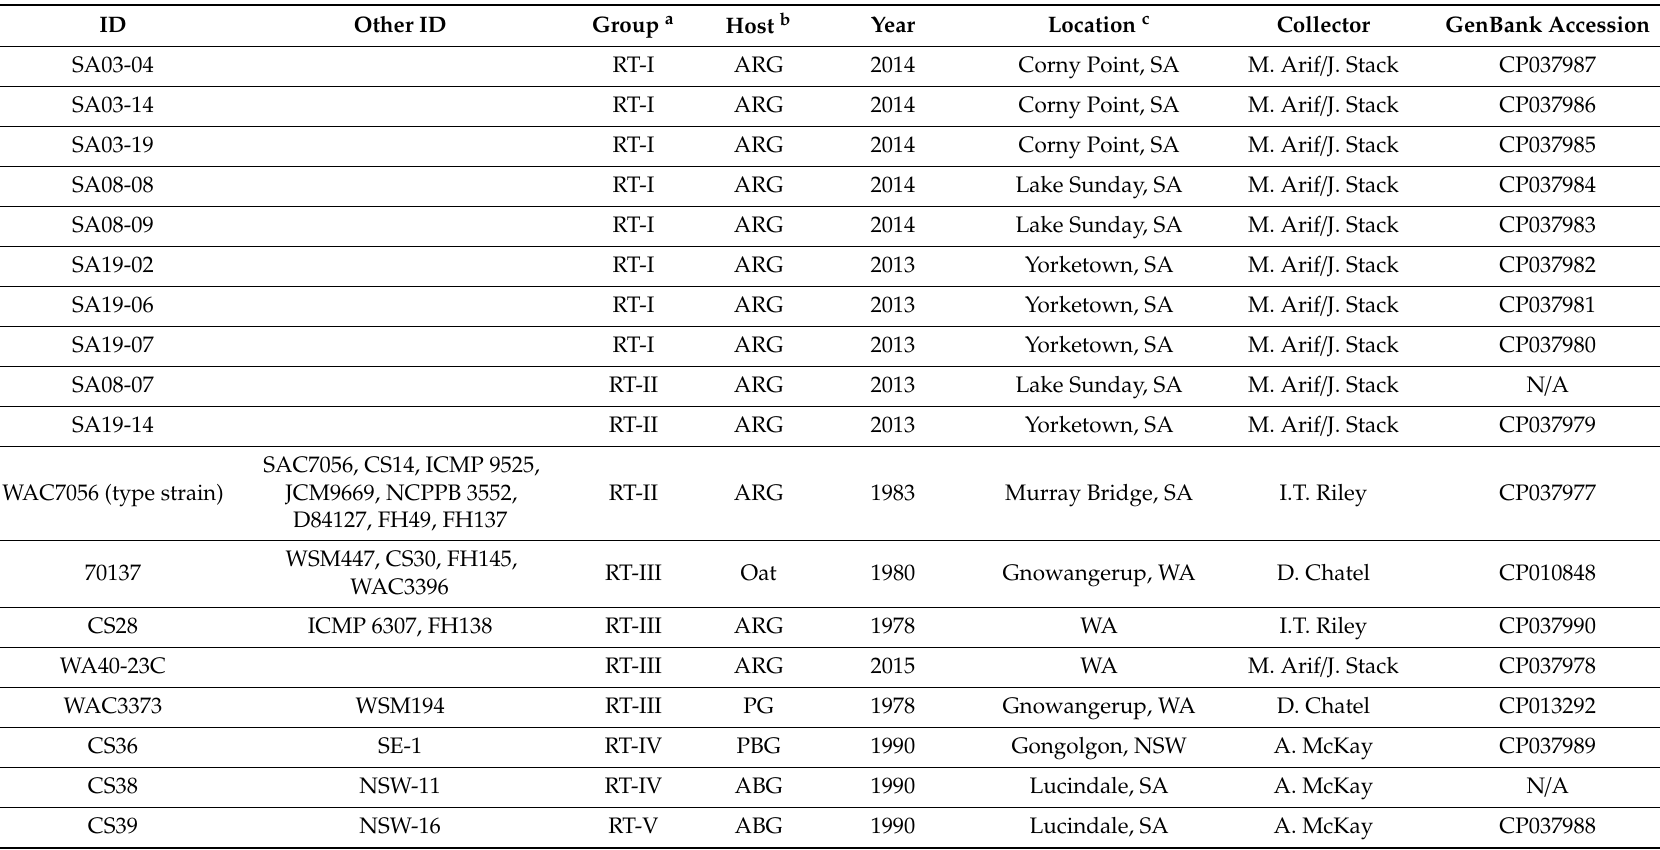
Table 1. Rathayibacter toxicus strains used in this